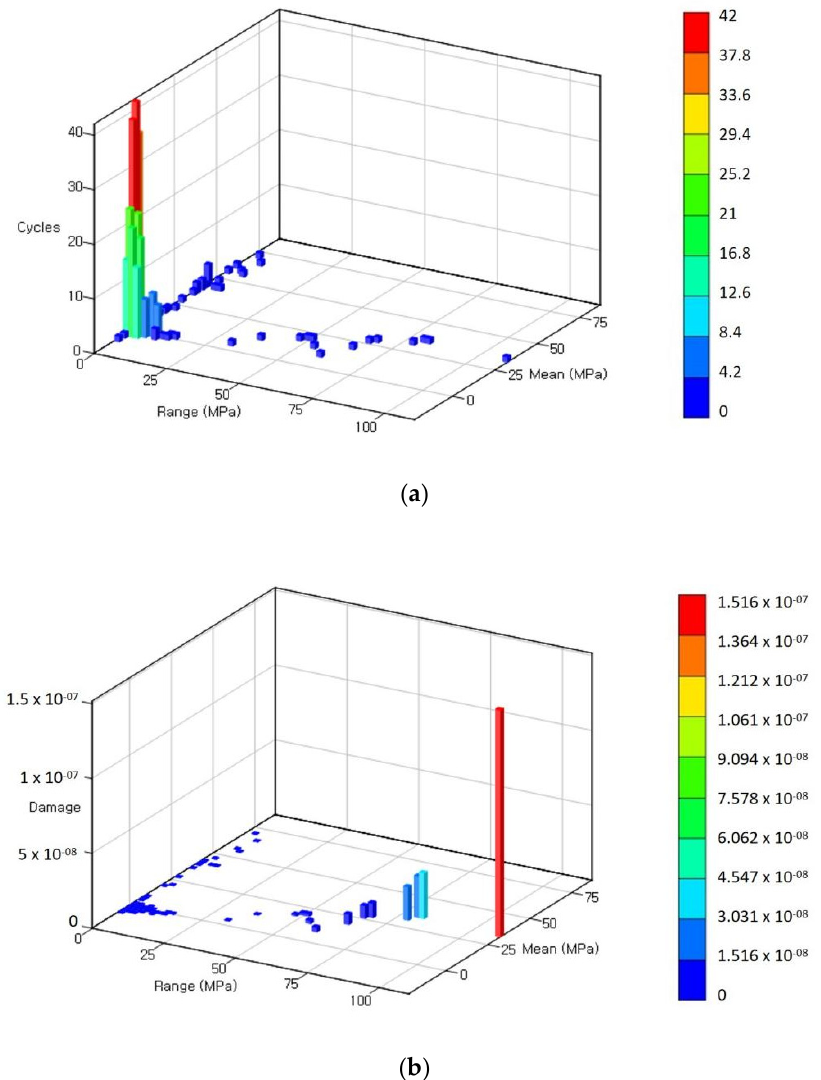
Figure 13. ( a ) Rain-flow counting result and ( b ) Damage sum histogram of strain gauge S_14 when engine speed is 750 rpm and planting distance is 0.35 m.